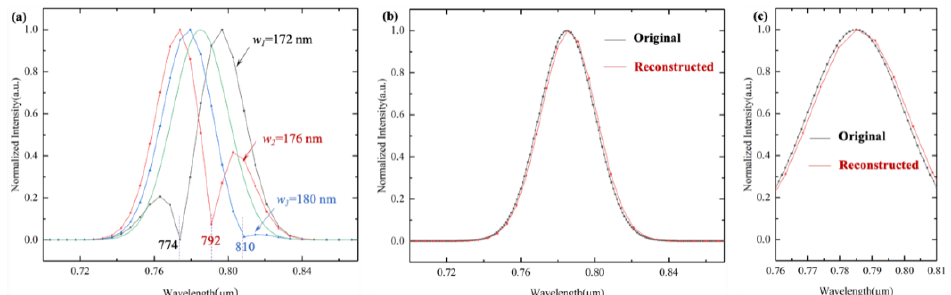
Figure 4. ( a ) Reconstructed spectral information under different nanowire widths. ( b ) Reconstructed spectral information while the nanowire width of 100 nm and the original spectrum, ( c ) local amplification in ( b ).